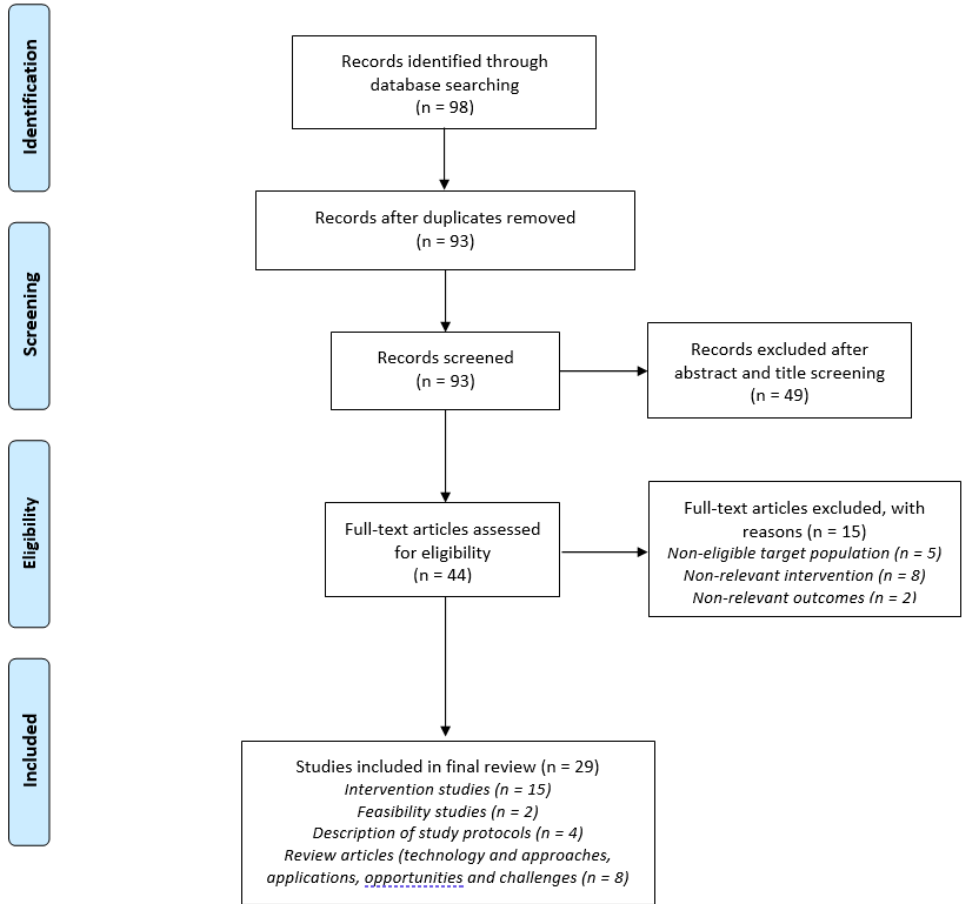
Figure 1. Flow chart according to the Preferred Reporting Items for Systematic Reviews and Meta-Analyses (PRISMA) method for the literature review search process which was conducted. See text for details [24].